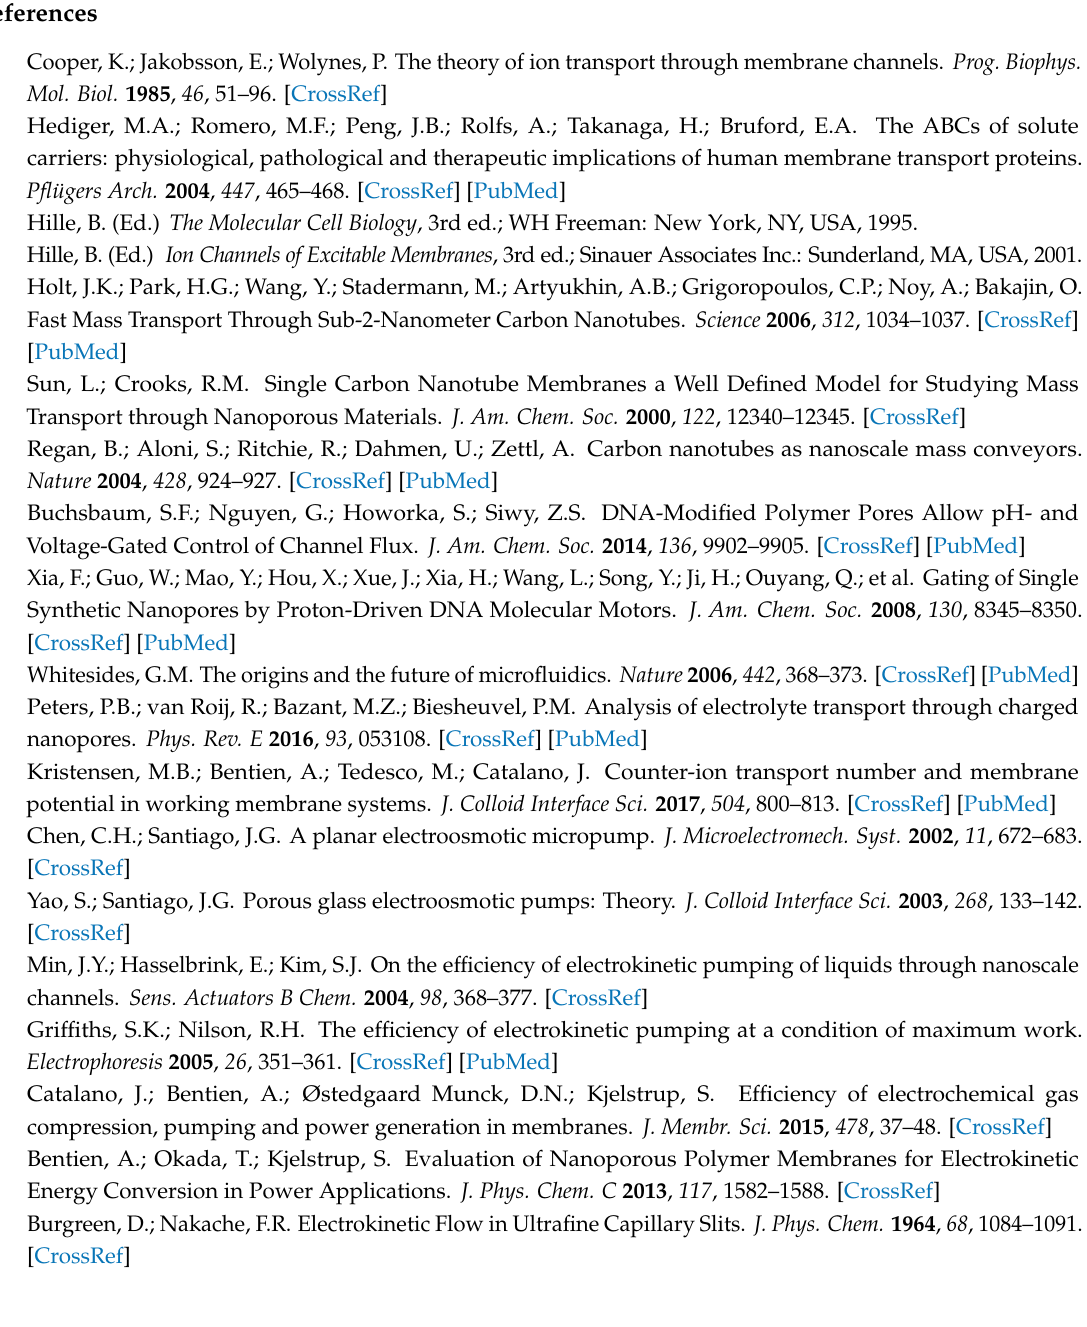
Figure S1: Experimental data (normalized) and best fitting for the electro-osmotic flow and voltage driven by an alternating current at several frequencies, Figure S2: Normalized mass flow, electrical potential difference, and current (I), Amplitudes for the differential mass and electrical current used in the normalization reported in Figures S1 and S2, Video S1: